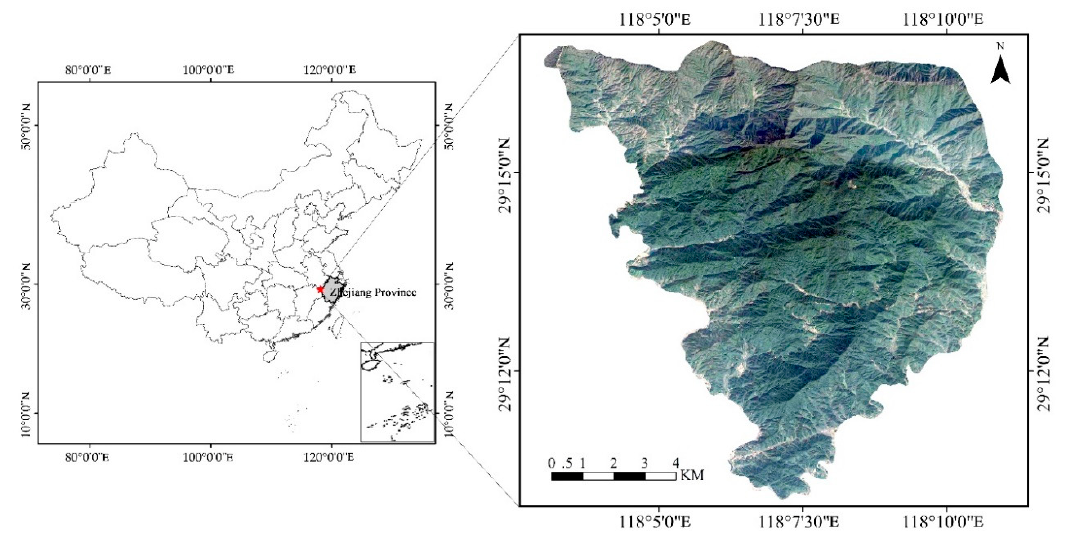
Figure 1. The location of the study site in the Gutianshan National Nature Reserve in Kaihua County, Zhejiang province, China. The red star represents the Gutianshan National Nature Reserve.